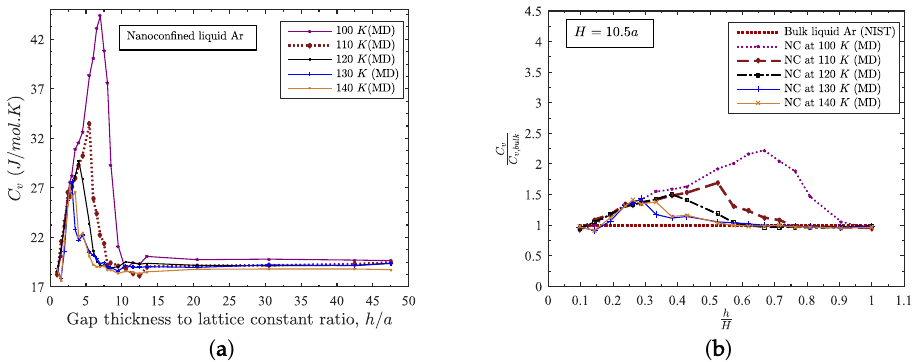
Figure 7. Size and temperature effect on heat capacity of nanogap confined liquid. (a) Actual, (b) normalized.